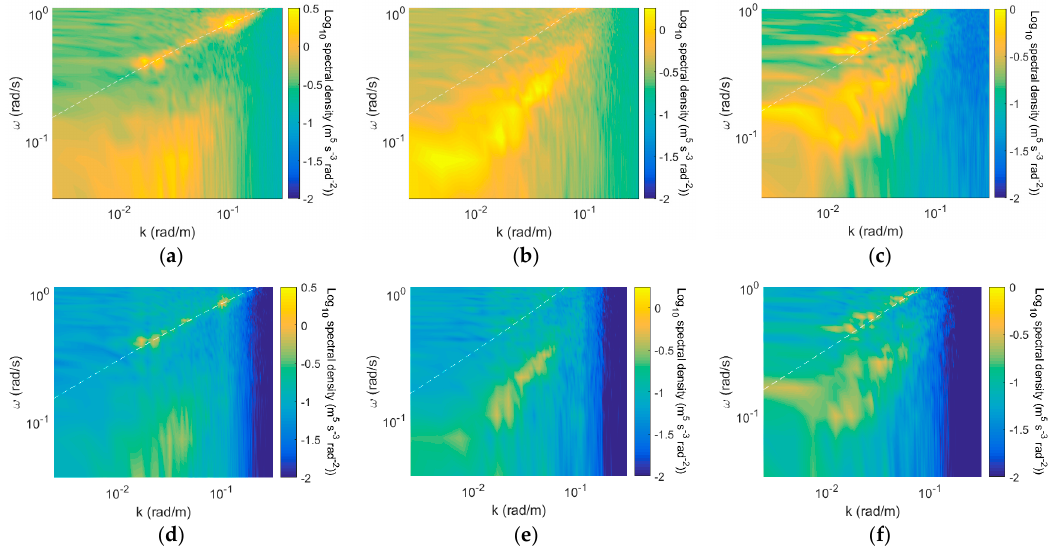
Figure 6. Panels ( a – c ) show the k - ω spectrum for UM dataset 8, UM dataset 7, and APS dataset 7, respectively. Panels ( d – f ) show the k - ω spectrum for the POD reconstructions with the most accurate H s (“best mode”). The linear dispersion relationship for ocean surface waves is shown as the white dotted line for reference.